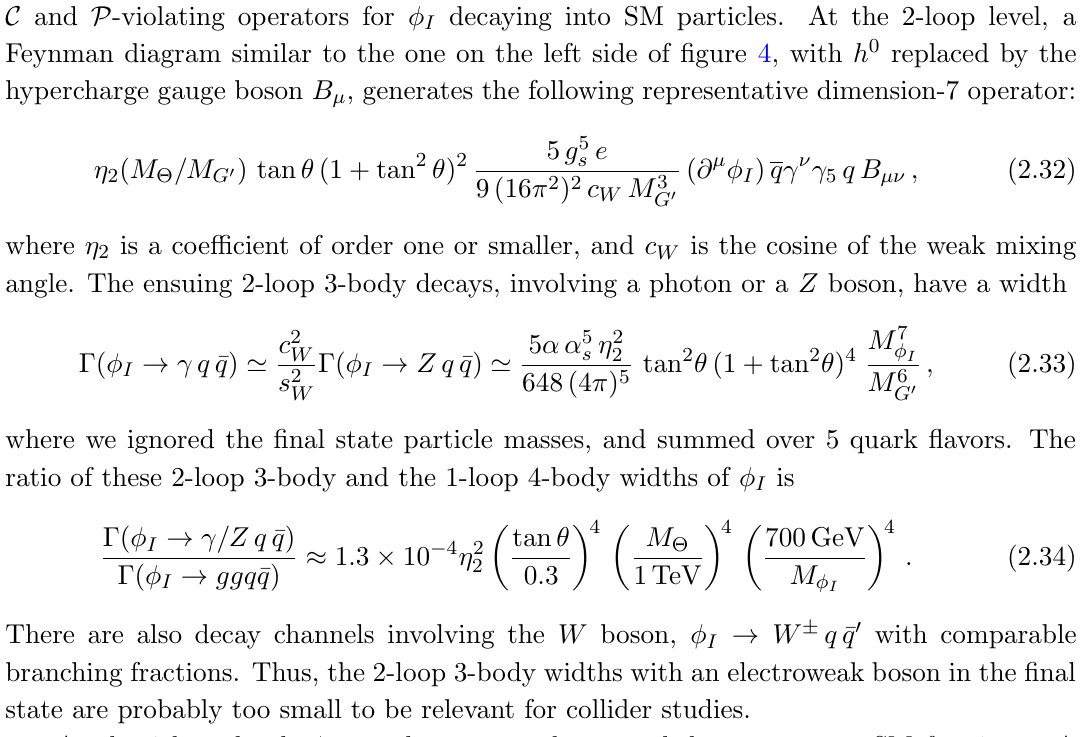
-odd scalar when M (cid:30) CP (cid:13)Z ; ZZ ; W + W (cid:0) at three !